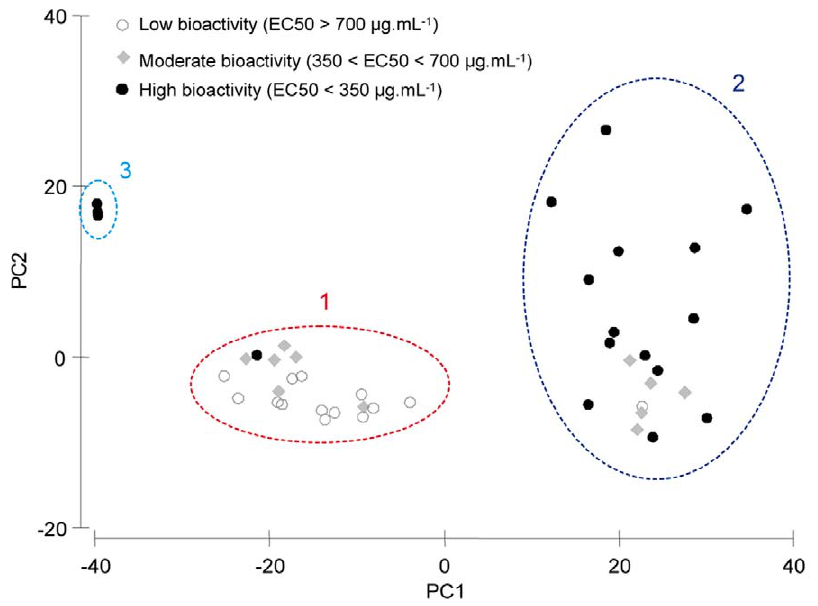
Figure 4. Relationship between the bioactivity and metabolic phenotypes of Oscarella balibaloi . The scatterplot of the metabolic fingerprint data set was analyzed by PCA. The PC1 explains 70.2% of variability and PC2 explains 11.3%.